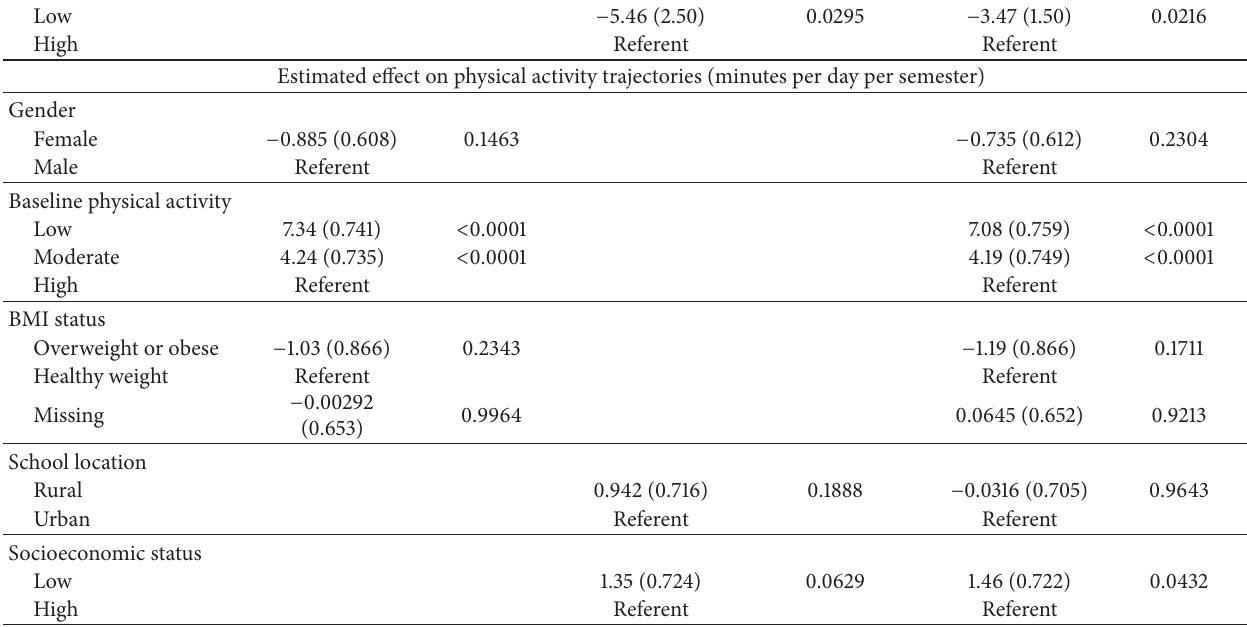
Referent categories are identified as